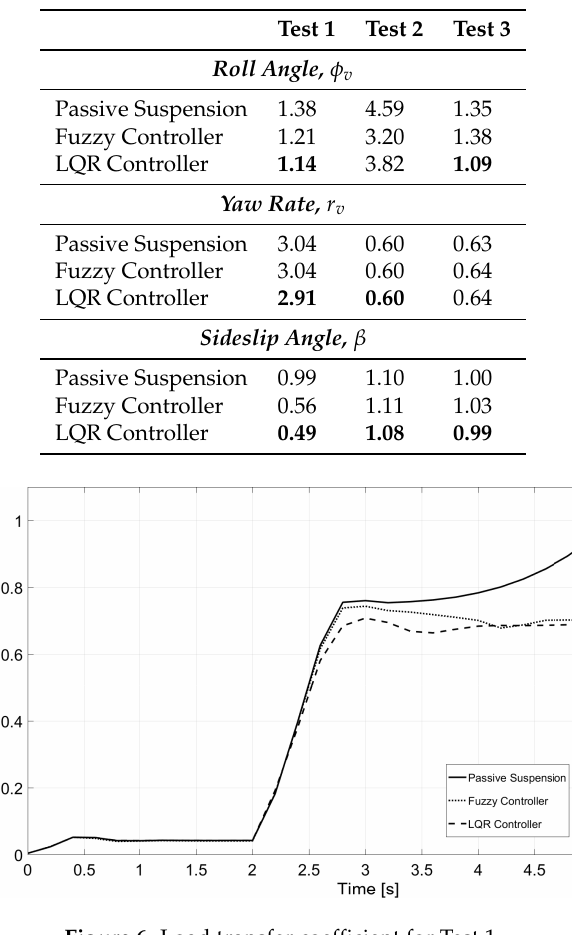
Figure 6. Load transfer coefficient for Test 1.